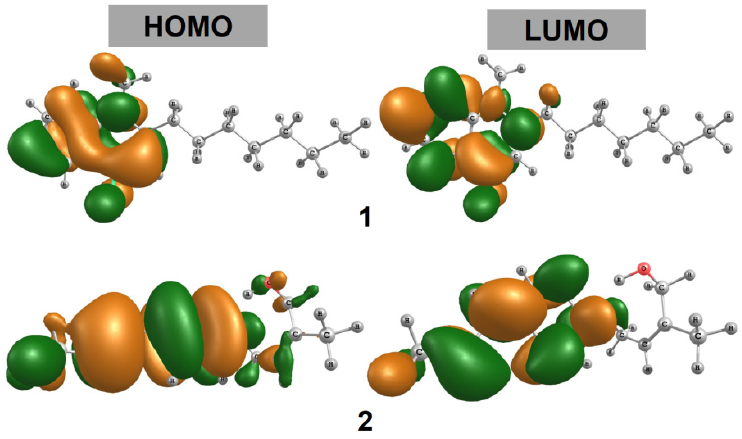
Figure 6. HOMO and LUMO of isolated compounds 1 and 2 in T. ruticarpum calculated by DFT at the level of theory M052X/def2-TZVP. The different colours (orange and green) refer to the deformation of electron densities, i.e. from green to orange. Nevertheless, an in-depth disscusion is unnecessary for quantum-unrelated analysis. Table 2. Quantum chemical parameters of the isolated compounds 1–2 from T. ruticarpum calculated by NBO analysis at level BP86/def2-TZVPP including HOMO energy ( E HOMO ), LUMO energy ( E LU MO ), energy gap ( Δ E GAP ); ionization potential